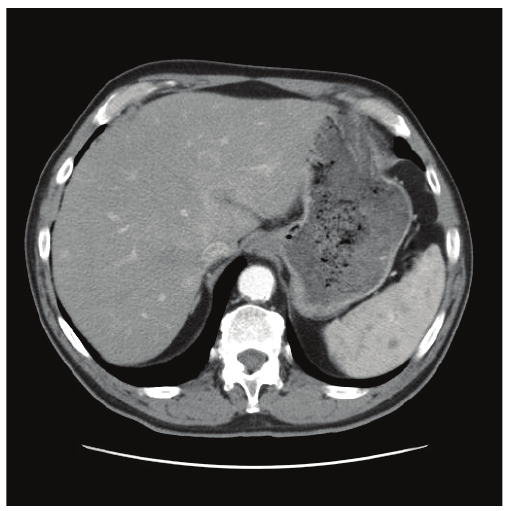
Figure 1: Multiple hypodense areas within the spleen